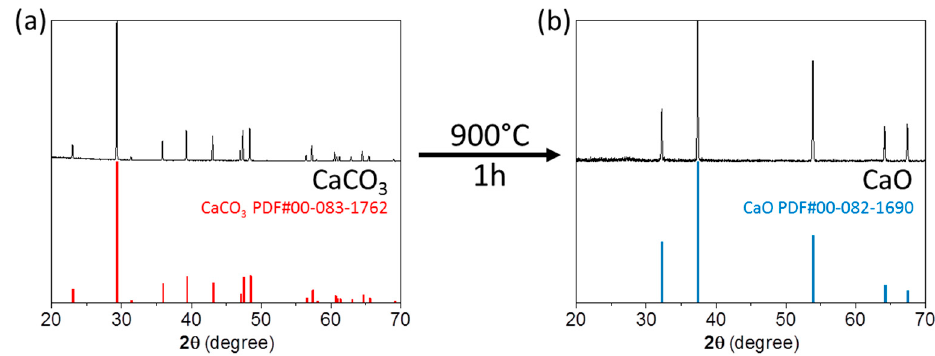
Figure 1. X-ray diffraction (intensity) patterns obtained from commercially available CaCO 3 ( a ) and the resultant CaO, obtained after thermal decomposition ( b ).